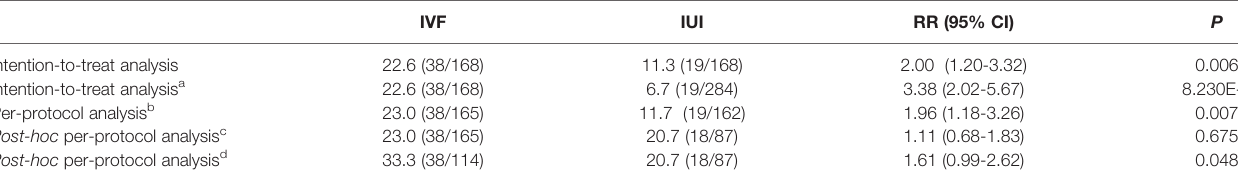
TABLE 5 | Livebirths by intention-to-treat and per-protocol analyses.